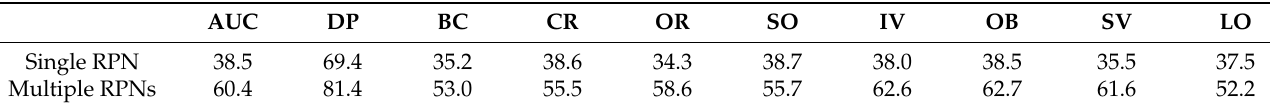
Table 10. Inner module ablation study by comparing the proposed method and the variants of our method on the UAVDT